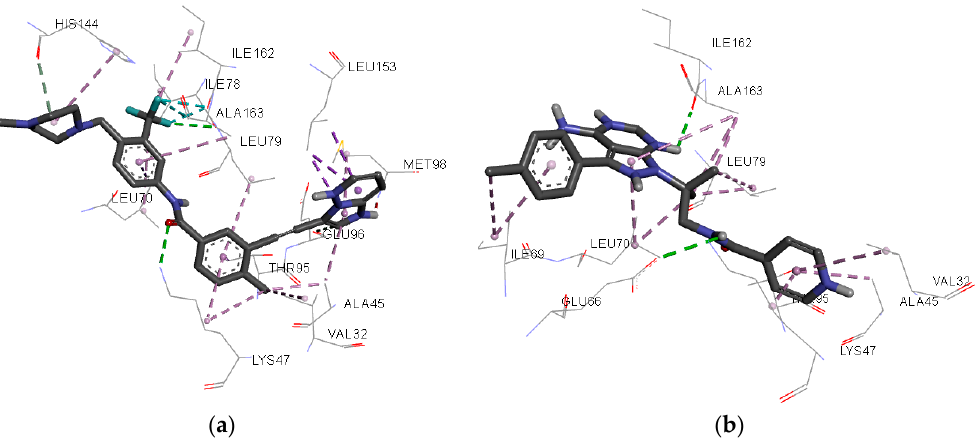
Figure 8. Individual net of interactions and contacts between RIPK2 (from PDB ID 4C8B) and ( a ) Ponatinib and ( b ) WEHI-345, thus calculated using the AutoDock/Vina software.